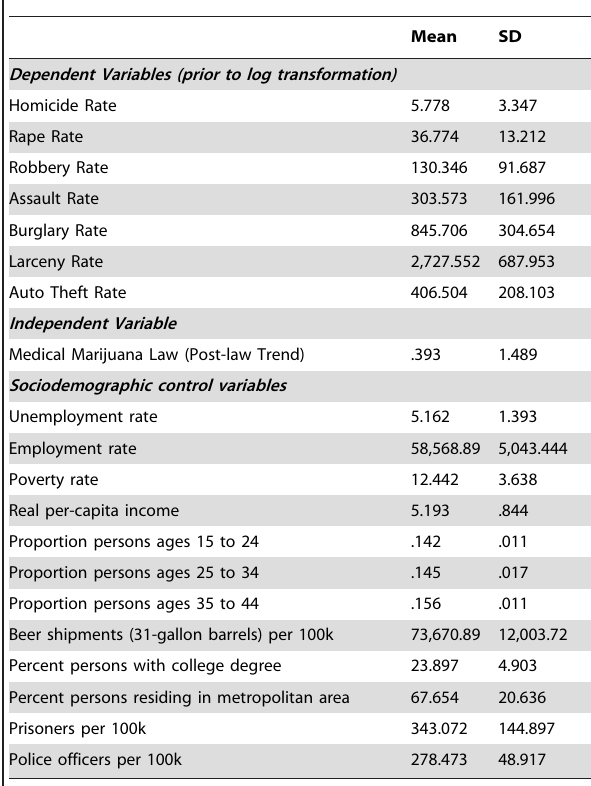
Table 1. Summary